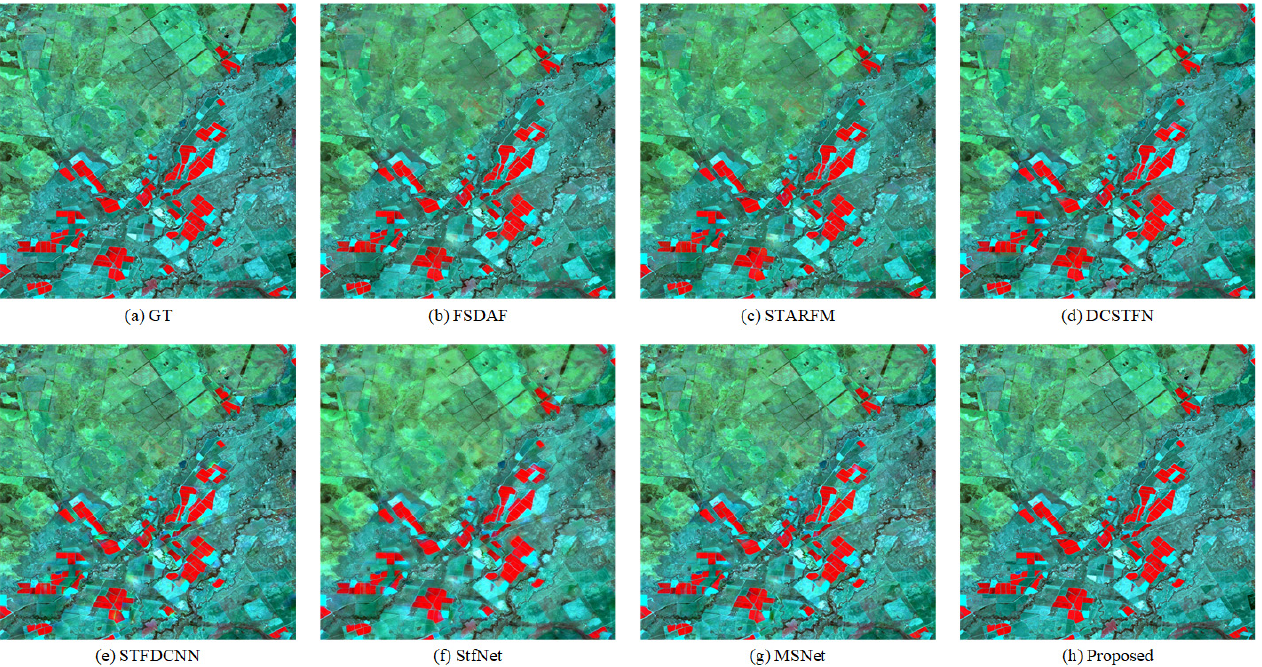
Figure 9. Comprehensive prediction results for the target Landsat image (14 February 2005) in LGC dataset. Comparison methods include FSDAF [11], STARFM [8], DCSTFN [23], STFDCNN [18], StfNet [19], and MSNet [36], which are represented by ( b – g ) in the figure respectively. ( a ) represents the ground truth (GT), and ( h ) represents the proposed method.